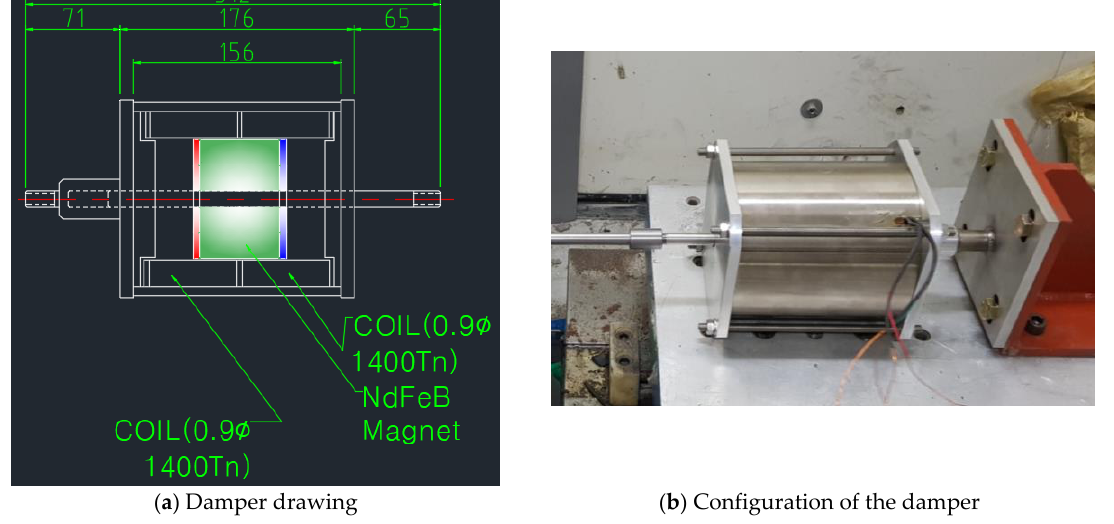
Figure 3. EM damper design drawing and configuration. Table 3. Characteristic test cases.